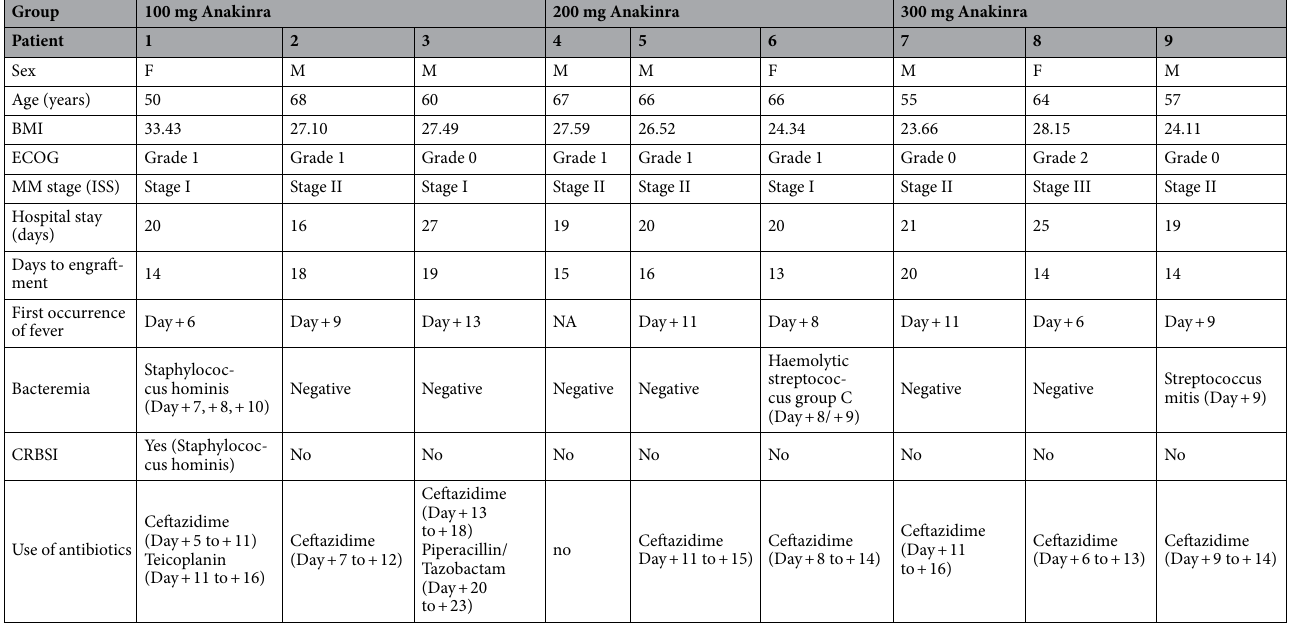
Table 2. Patient demographics and bacteremia data AFFECT-1 Phase IIA